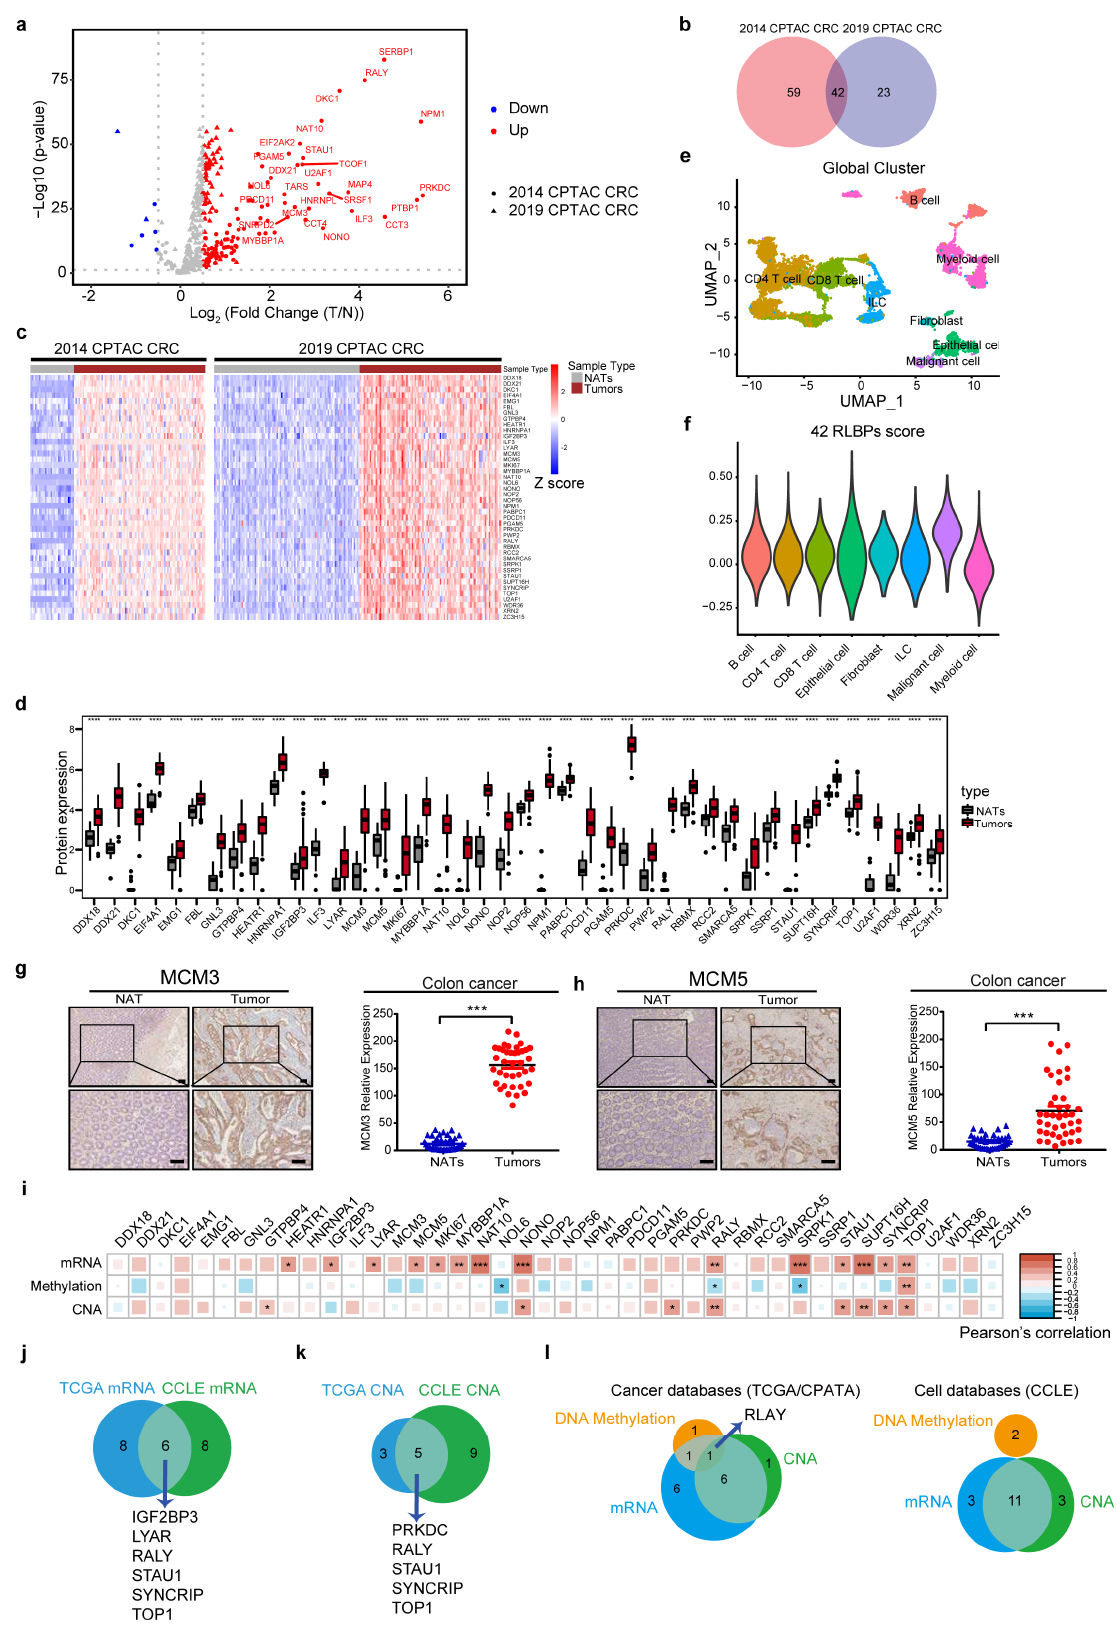
Figure 5. The expression and correlation of 42 RLBPs in colorectal tumors. ( a ) Volcano plot showing 204 RLBPs proteomics in tumors versus normal adjacent tissues (NATs) in two colorectal